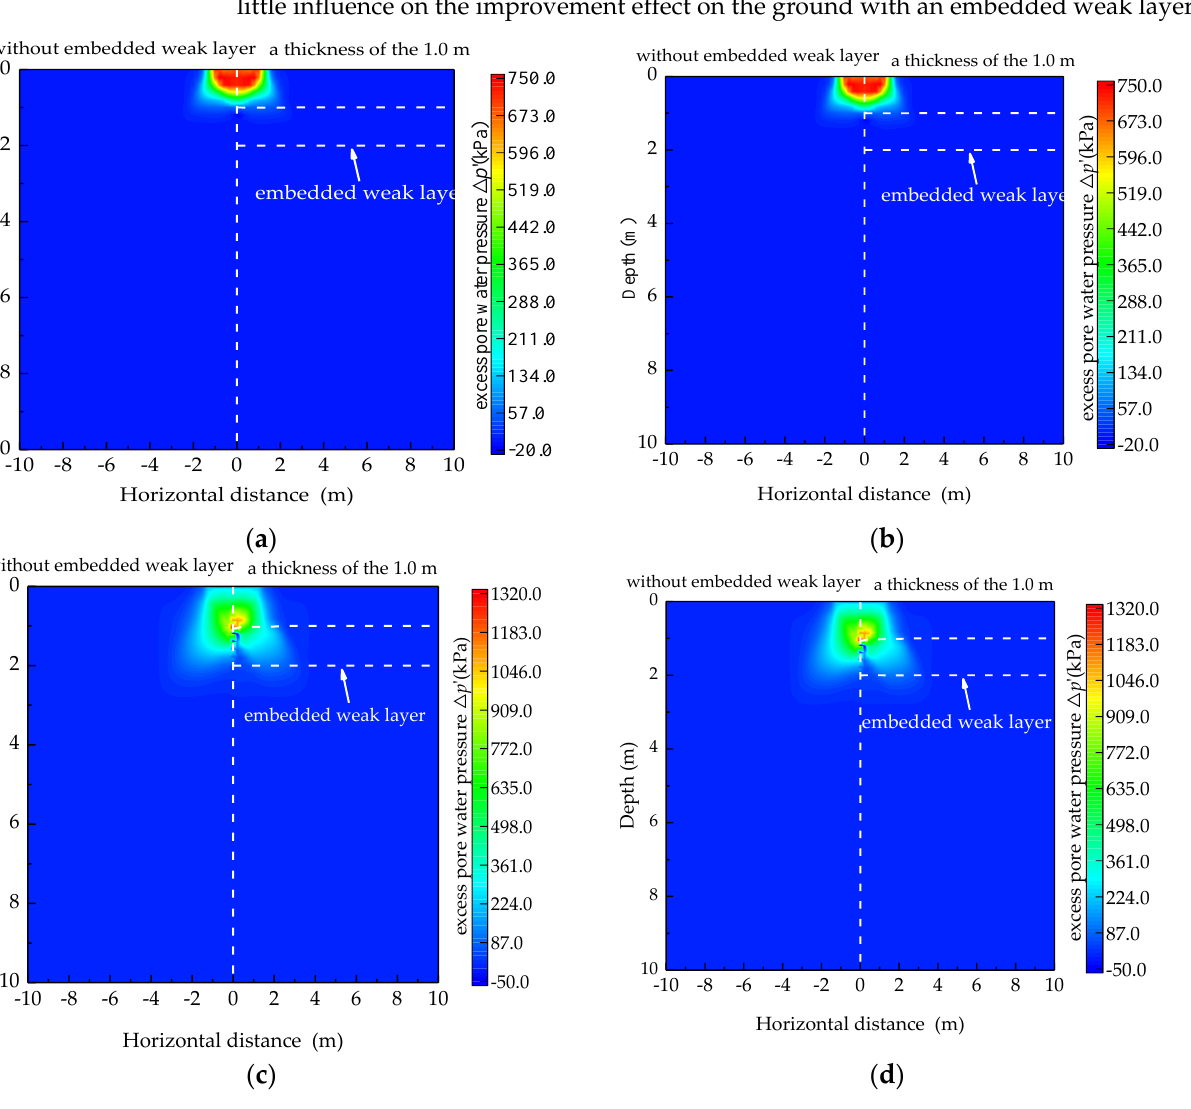
Figure 7. Distribution of Δ p in grounds with and without a weak layer during DC. ( a ) t = 0.01 s; ( b ) t = 0.02 s; ( c ) t = 0.04 s; ( d ) t = 0.1 s.